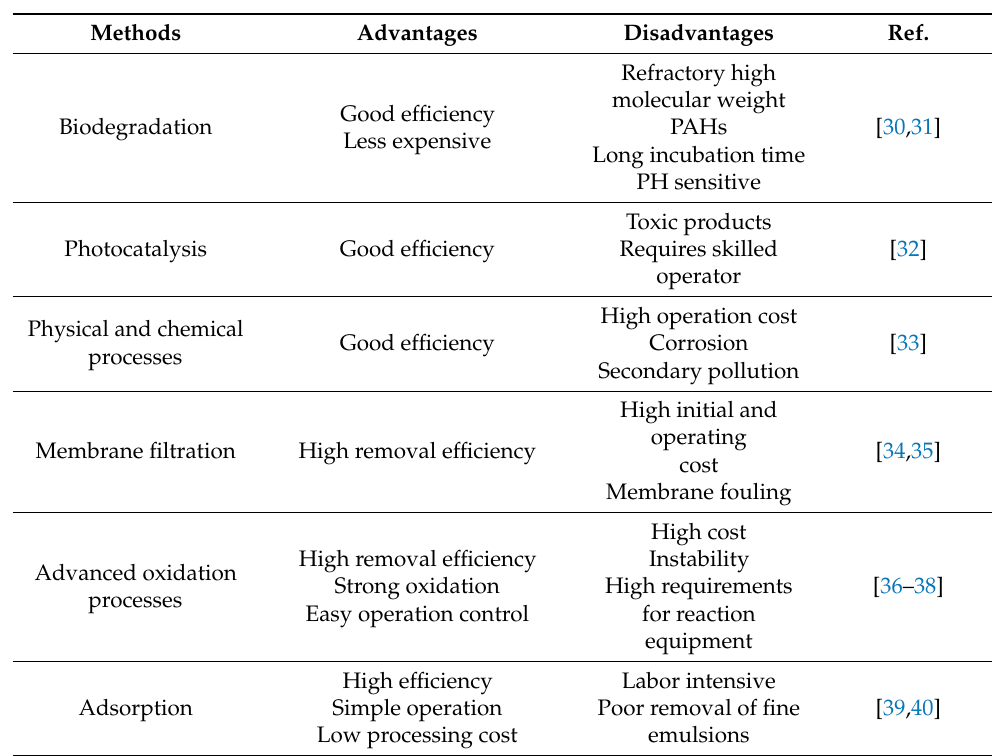
Table 2. Methods for removal Nap.